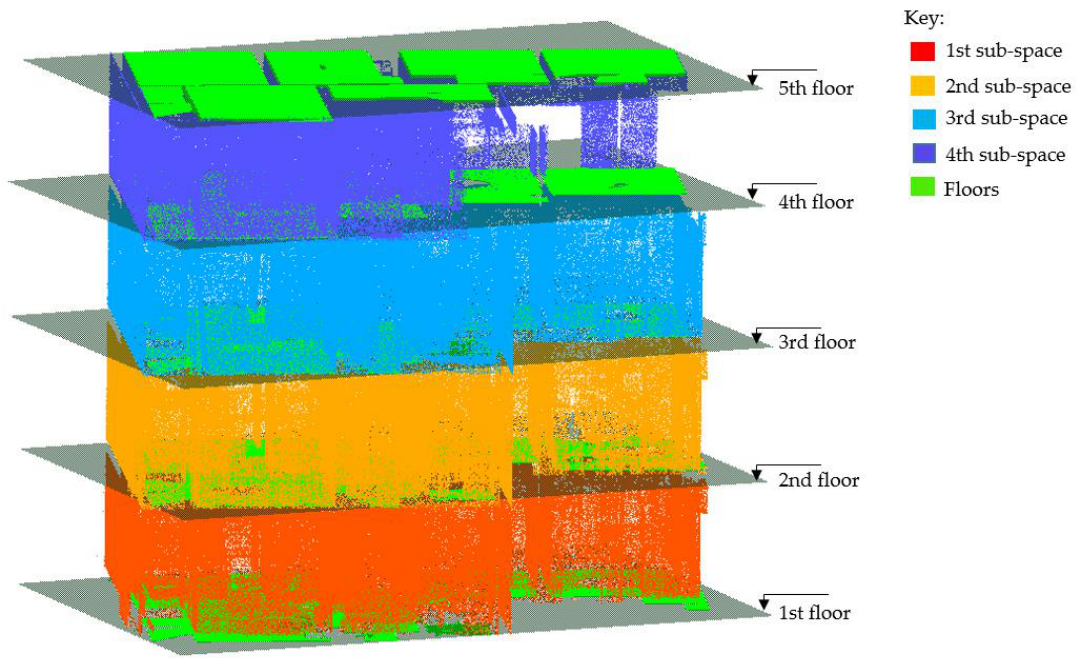
Figure 13. Vertical subspaces by floor